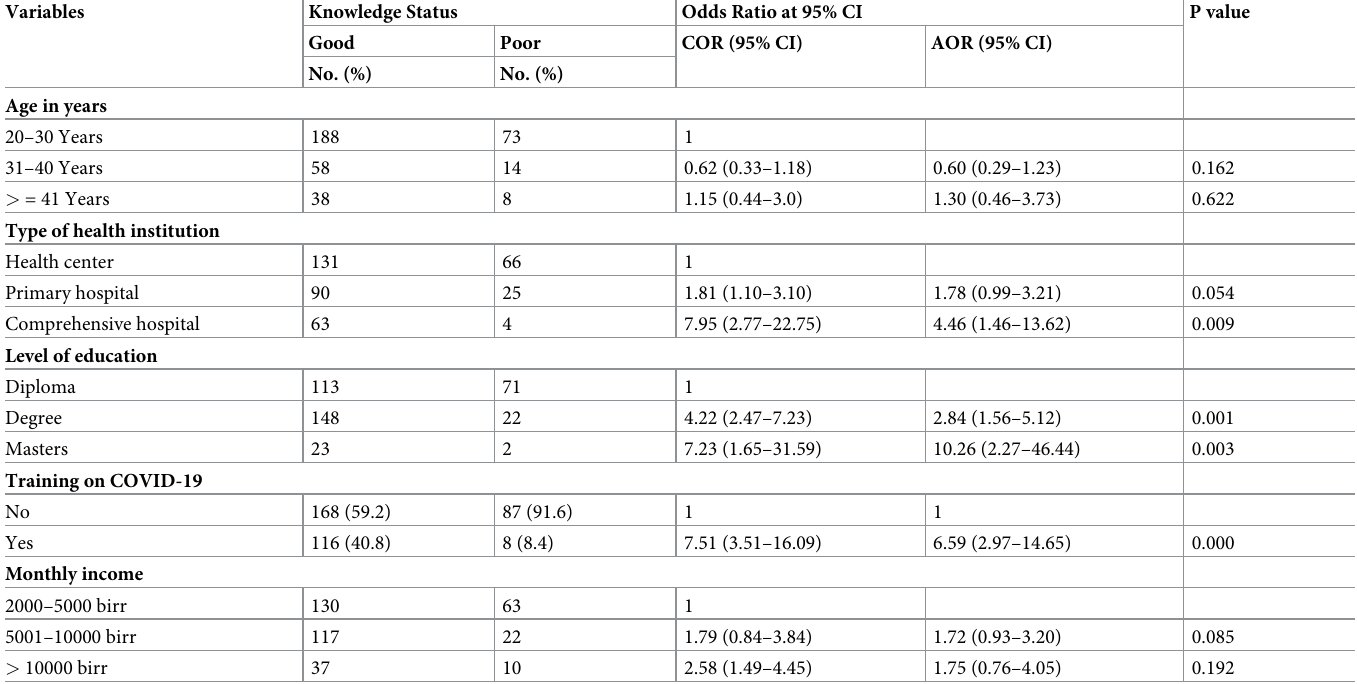
Table 2. Factors associated with Knowledge of health care workers about COVID-19 in Silte zone, southern Ethiopia,